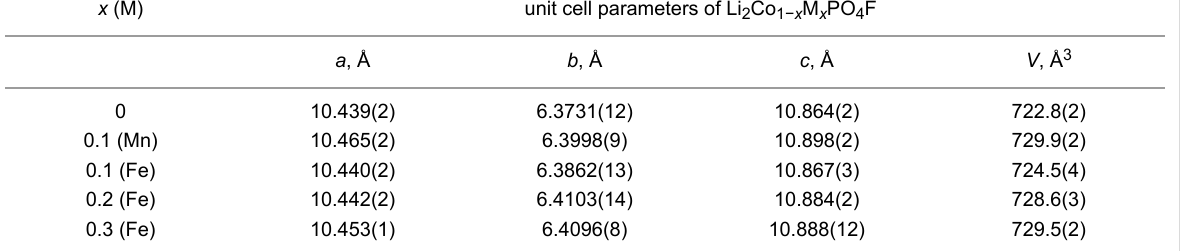
Table 1: Unit cell parameters of fluorophosphates Li 2 Co 1 − x M x PO 4 F (M = Mn, Fe).